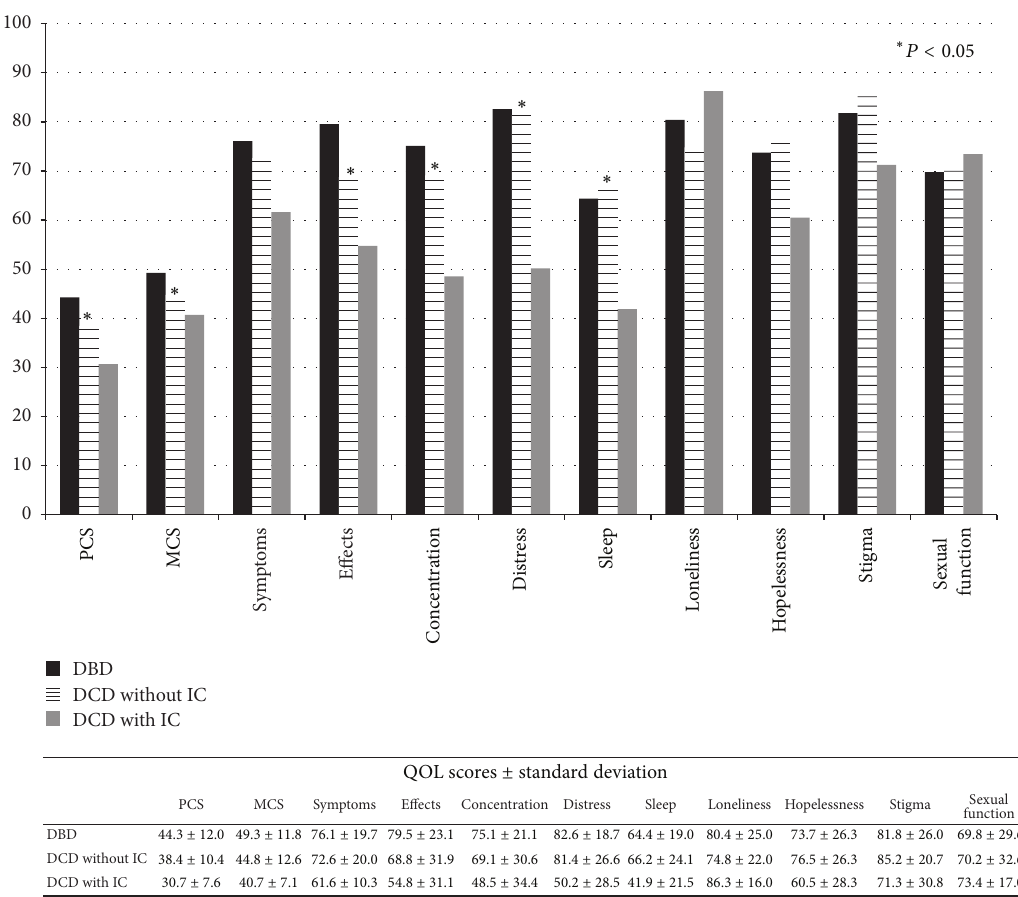
Figure 2: QOL scores in cohorts from the Short Form Liver Disease Quality of Life instrument. PCS: physical composite score, MCS: mental composite score, DCD: donation after cardiac death, DBD: donation after brain death, and IC: ischemic